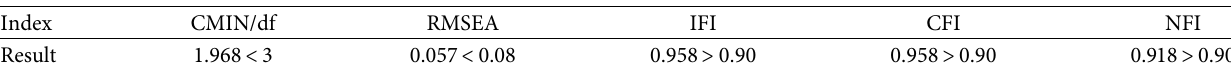
Figure 2: Results of the path analysis model. Table 6: Goodness-of-fit